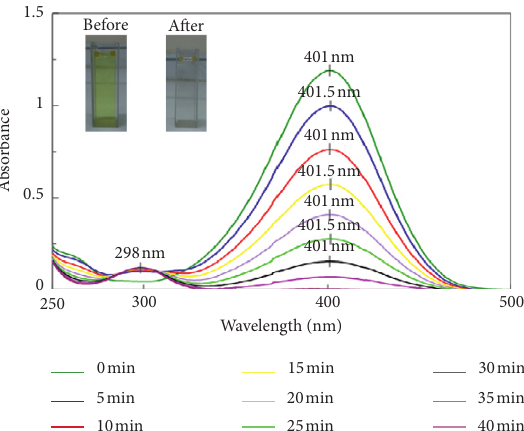
Figure 7: Time-dependent UV-vis spectra of the reduction of 4-nitrophenolate reduction by NaBH